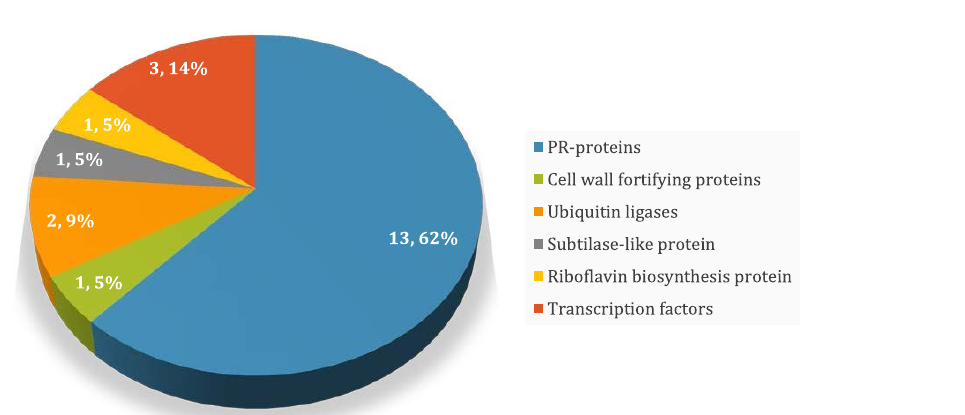
Fig. 2. Pie chart showing the breakdown of defense-associated genes according to respective functional group